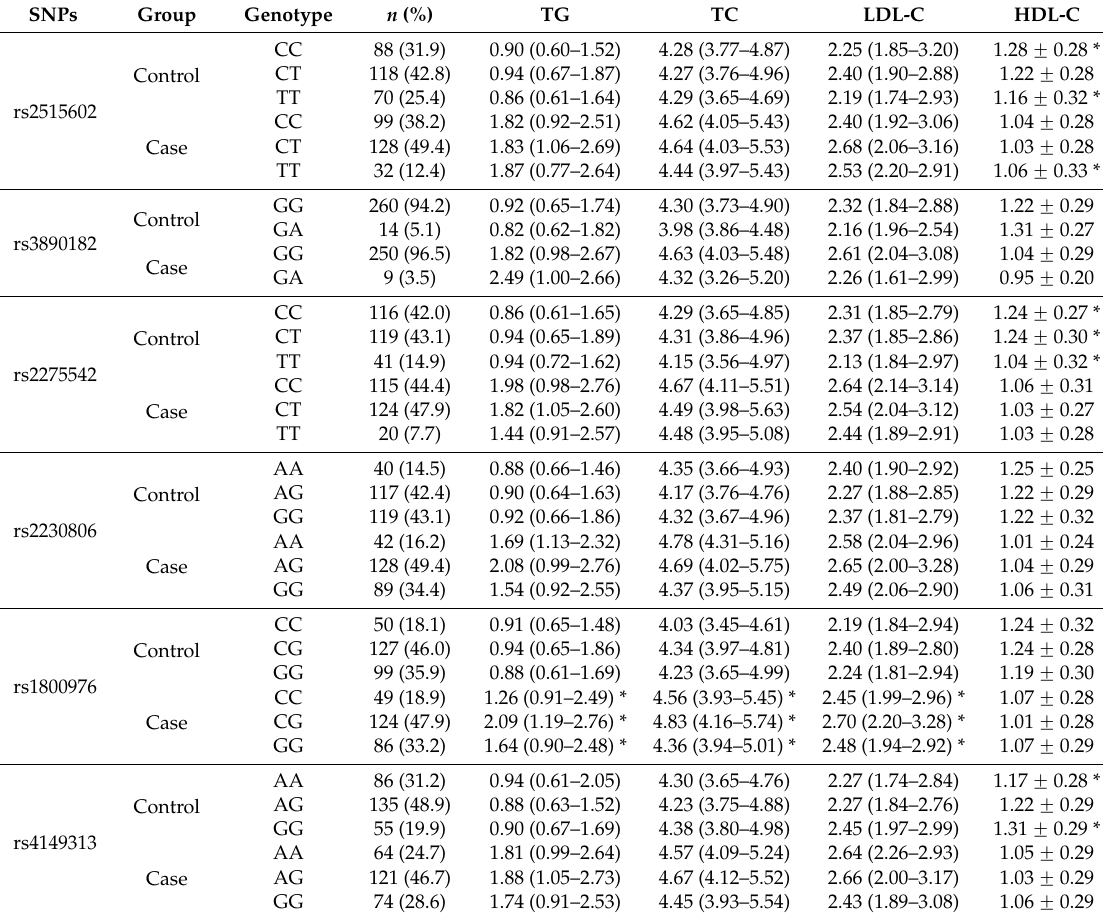
Table 7. The genotypes of six SNPs and serum lipid levels (mmol/L) between the subjects with normal weight and